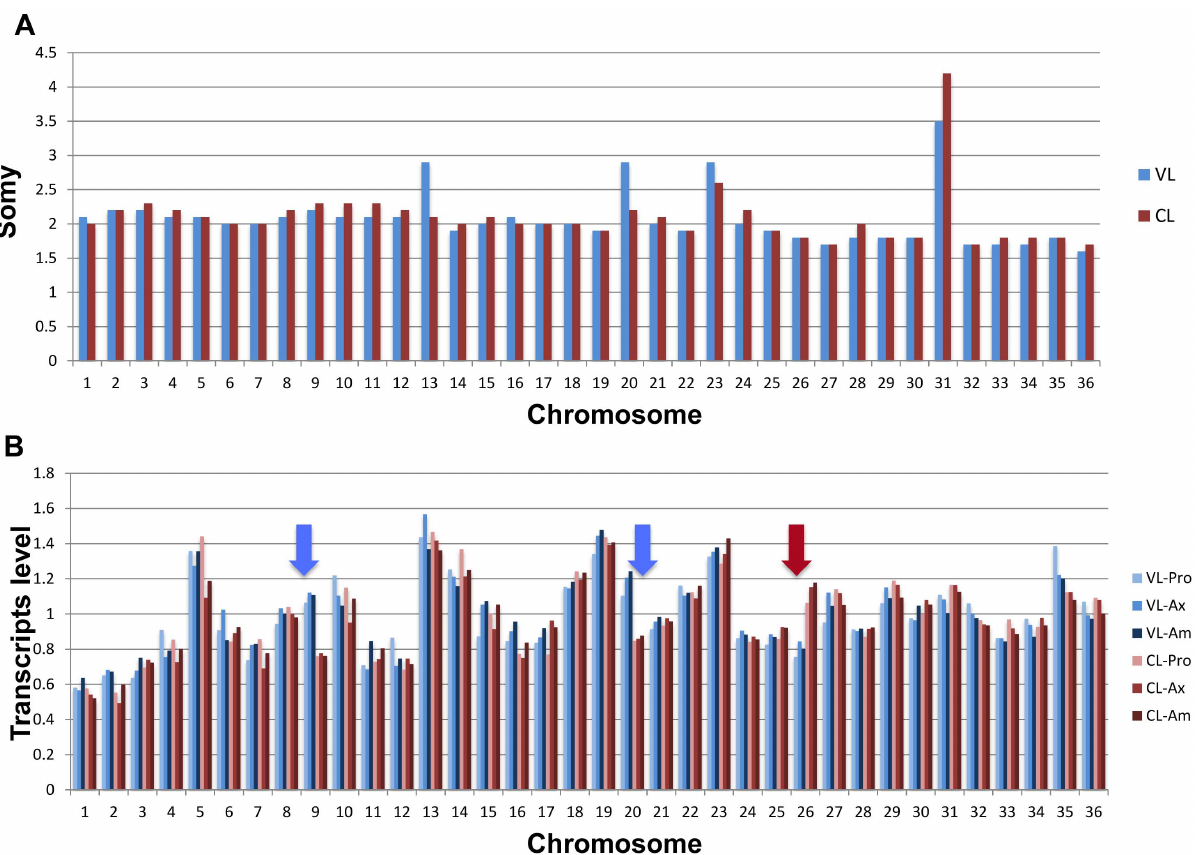
Figure 3. Chromosome copy number comparison between the VL-SL and CL-SL strains (Panel A). Read depth was scaled to give a value of 2 for disomic chromosomes. Comparison of chromosome transcript levels in the VL-SL and CL-SL strains ( Panel B ). Total RNA was prepared from promastigotes, axenic amastigotes and macrophages infected with the VL-SL and CL-SL strains. The cDNA libraries prepared from the RNAs were subjected to SL-sequencing and the cDNA coverage from each chromosome was normalized to the entire genome. Pro, axenic promastigotes; Ax, axenic amastigotes; Am, infected macrophage-derived amastigotes.